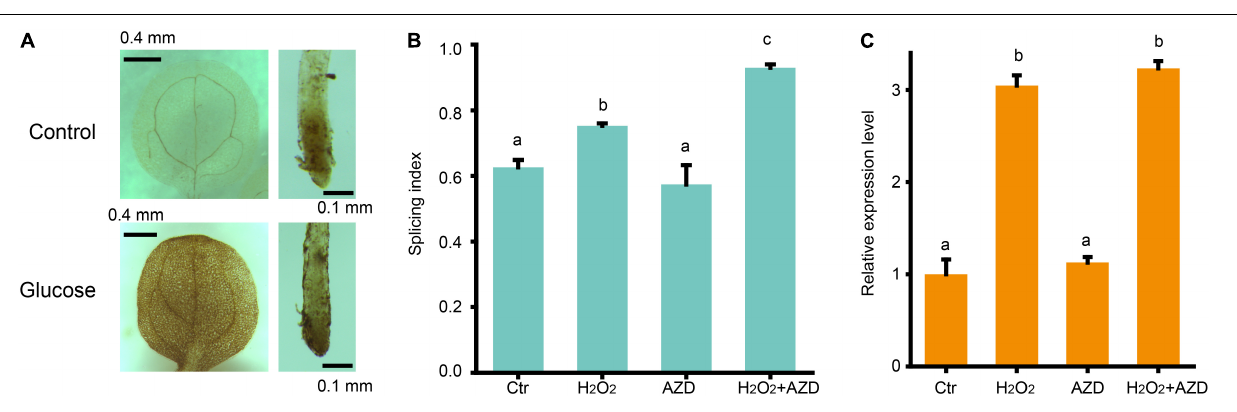
FIGURE 5 | ROS regulates AS pattern change of GRP7 downstream of TOR. (A) DAB staining for the leaves and roots of 7-day-old seedlings upon glucose stress. (B) The SI of GRP7 transcripts upon different treatments. (C) The expression levels of GRP7 upon different treatment. Ctr, 0% glucose; H 2 O 2 , 50 µ M H 2 O 2 ;